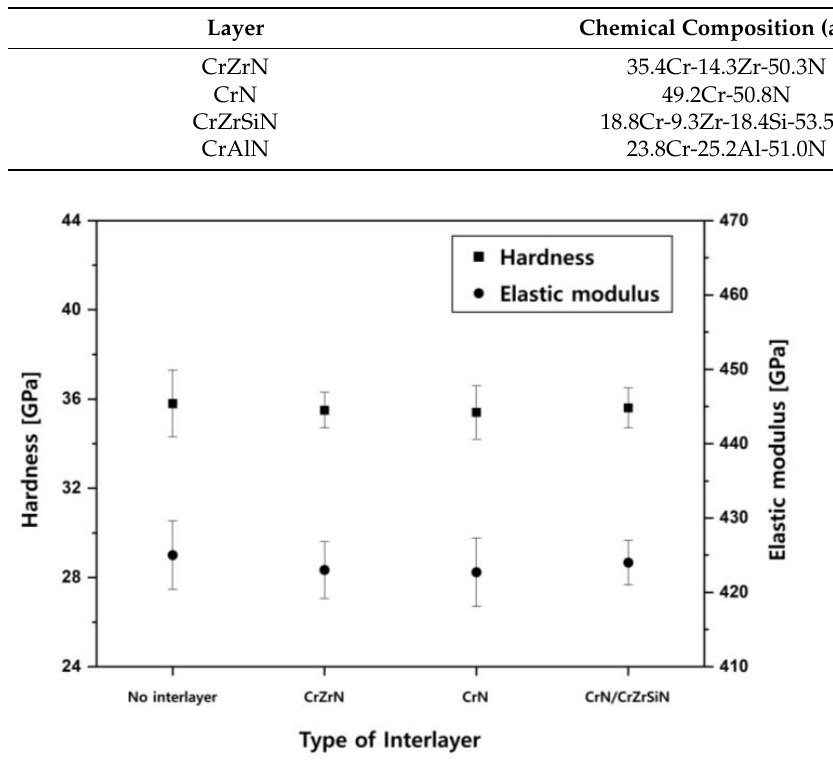
Figure 2. Hardness and elastic modulus of the CrAlN coatings with three interlayers.